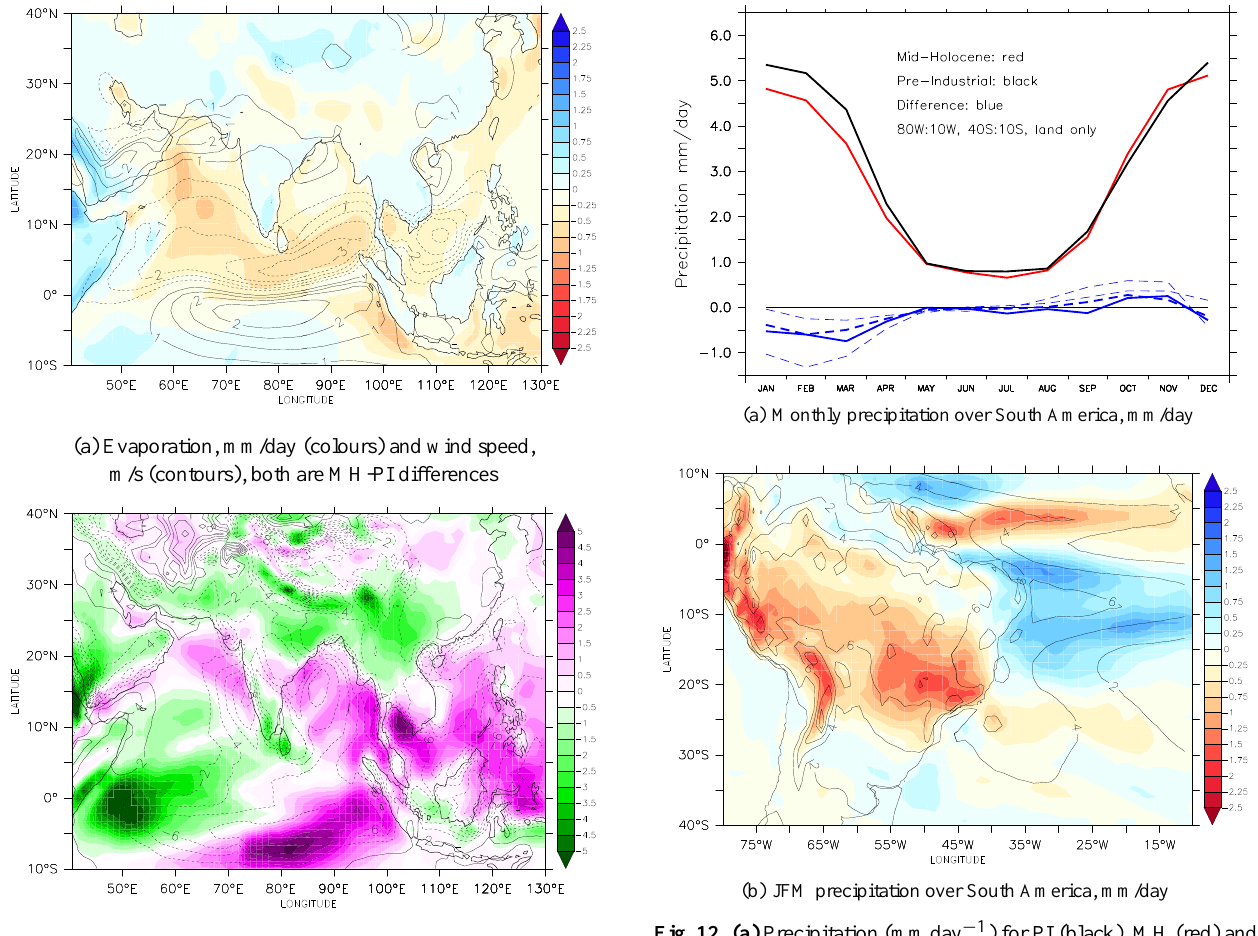
Fig. 12. (a) Precipitation (mmday − 1 ) for PI (black), MH (red) and Fig. 12. Figure (a): Precipitation (mm/day) for PI (black), MH difference MH-PI (blue) throughout the year. The dashed blue lines (red) and difference MH-PI (blue) throughout the year. The dashed Fig. 12. Figure (a): Precipitation (mm/day) for PI (black), MH are differences in the PMIP2 models: the thick dashed blue line is blue lines are differences in the PMIP2 models: the thick dashed (red) and difference MH-PI (blue) throughout the year. The dashed the average of 12 PMIP2 models (see Fig. 15 for references). The blue line is the average of 12 PMIP2 models (see Figure 15 for blue lines are differences in the PMIP2 models: the thick dashed thin dashed blue lines are individual PMIP2 model results with the references). The thin dashed blue lines are individual PMIP2 model blue line is the average of 12 PMIP2 models (see Figure 15 for results with the largest and smallest changes for South-America in largest and smallest changes for South-America in JFM. (b) The references). The thin dashed blue lines are individual PMIP2 model JFM. Figure (b): the spatial pattern of precipitation differences in results with the largest and smallest changes for South-America in spatial pattern of precipitation differences in JFM. Colours indicate JAS. Colours indicate MH - PI differences, contours are absolute PI JFM. Figure (b): the spatial pattern of precipitation differences in MH-PI differences, contours are absolute PI values. Note that the values. Note that the colour scales are different than for the figures JAS. Colours indicate MH - PI differences, contours are absolute PI colour scales are different than for the figures in Sects. 3.1 and in Sections 3.1 and 3.2. values. Note that the colour scales are different than for the figures in Sections 3.1 and 3.2.